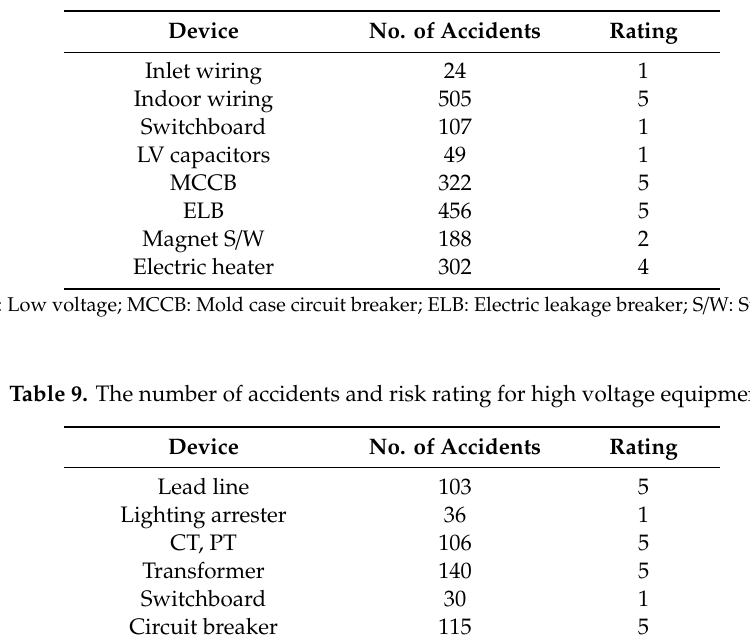
Table 8. The number of accidents and risk rating for low voltage equipment.